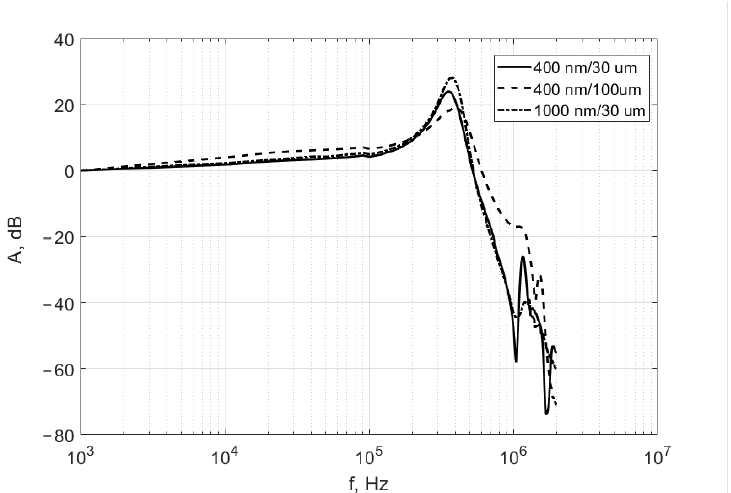
Figure 10. Frequency response of membranes with different parameters. Solid line-thickness is 400 nm, width of skid feet is 30 µ m; dashed line-thickness is 400 nm, width of skid feet is 100 µ m; dotted line-thickness is 1 µ m, width of skid feet is 30 µ